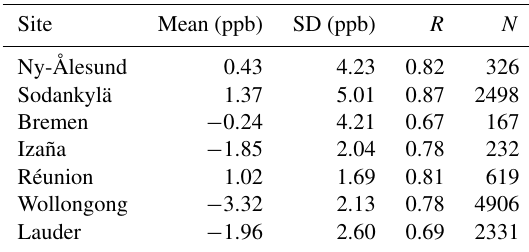
Table 4. NDACC-retrieved X N Table 5. The mean and the standard deviation (SD) of the difference in 2014 with different settings 2 O (spectroscopy + regularization + retrieval windows + a priori pro- between co-located hourly means of TCCON and NDACC data, to- file) at Réunion. gether with the correlation coefficient ( R ) and total number ( N ) of the co-located data